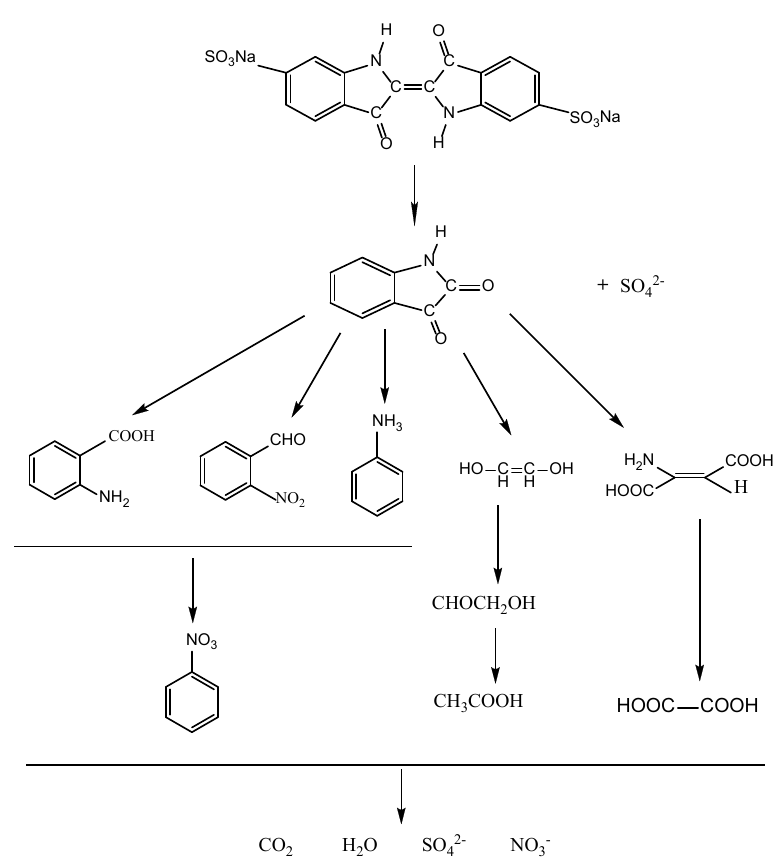
Figure 15. Suggested photocatalytic degradation pathway scheme for IC under visible light irradiation with the presence of ZnBiSbO at 800 °C for 35 h.